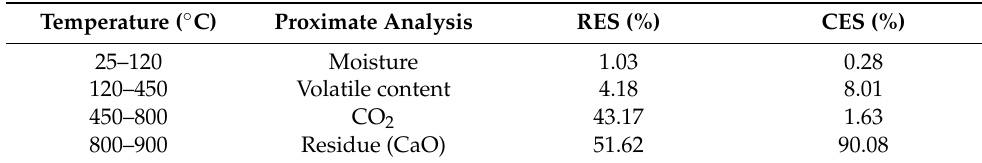
Table 3. Proximate analysis of raw and calcined eggshell (900 ◦ C).